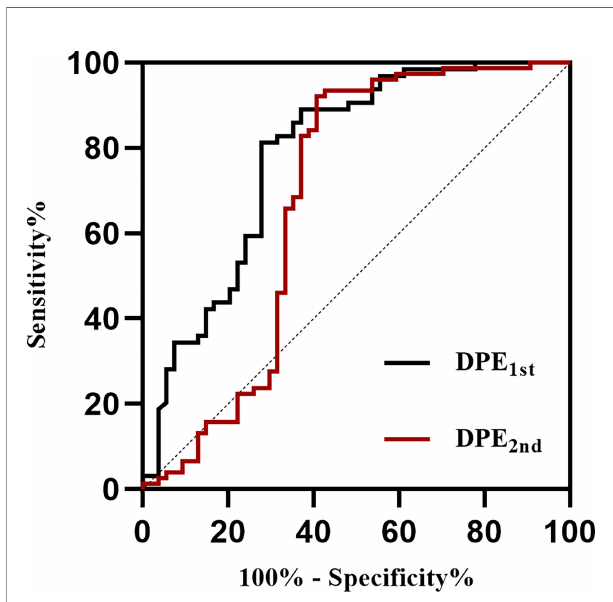
FIGURE 5 | Receiver operating characteristic curves of DPE to identify patients with poor outcomes at discharge. DPE, delayed perihematomal edema expansion. DPE 1st indicates DPE from 4-7days to 8-14days, and DPE 2nd indicates DPE from 8-14days to